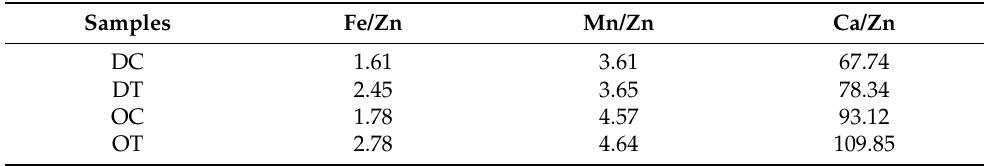
Table 4. PIXE elemental